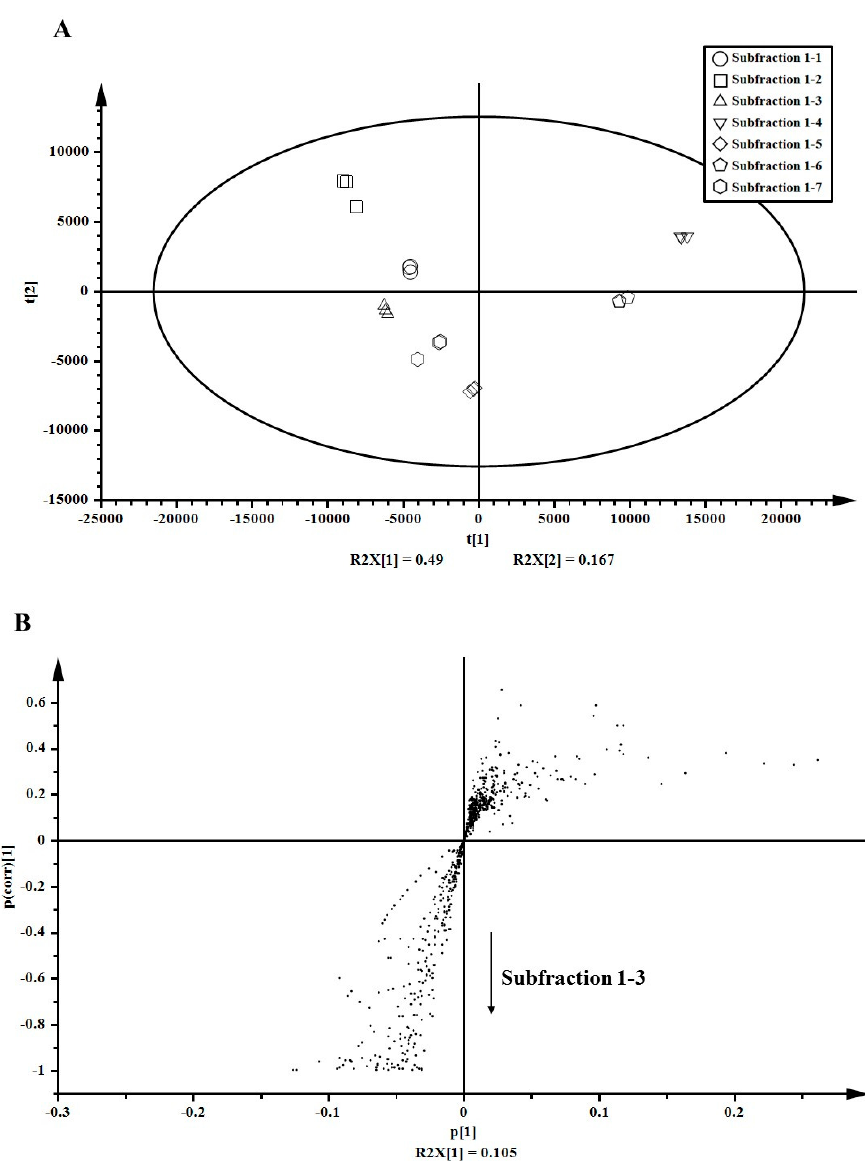
Figure. 3. Multivariate statistical analyses for metabolites in the sub-subfractions obtained from the 75% ethanol extract of Actinidia arguta leaves . ( A ) Score plot generated by principal component analysis (PCA). ( B ) S-plot generated by orthogonal partial least-squared discriminant analysis (OPLS-